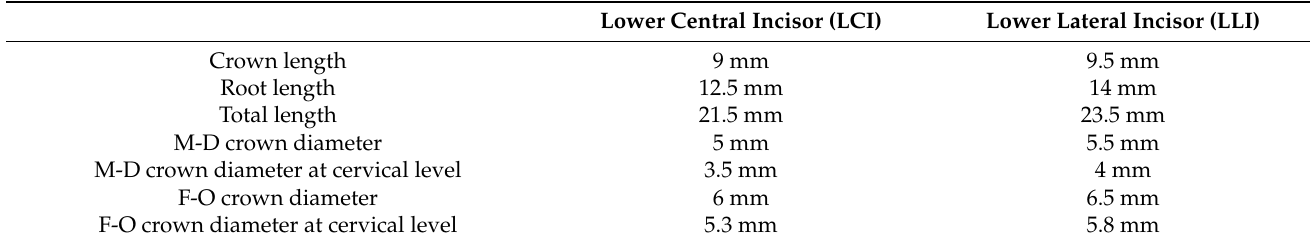
Table 1. Tooth dimensions